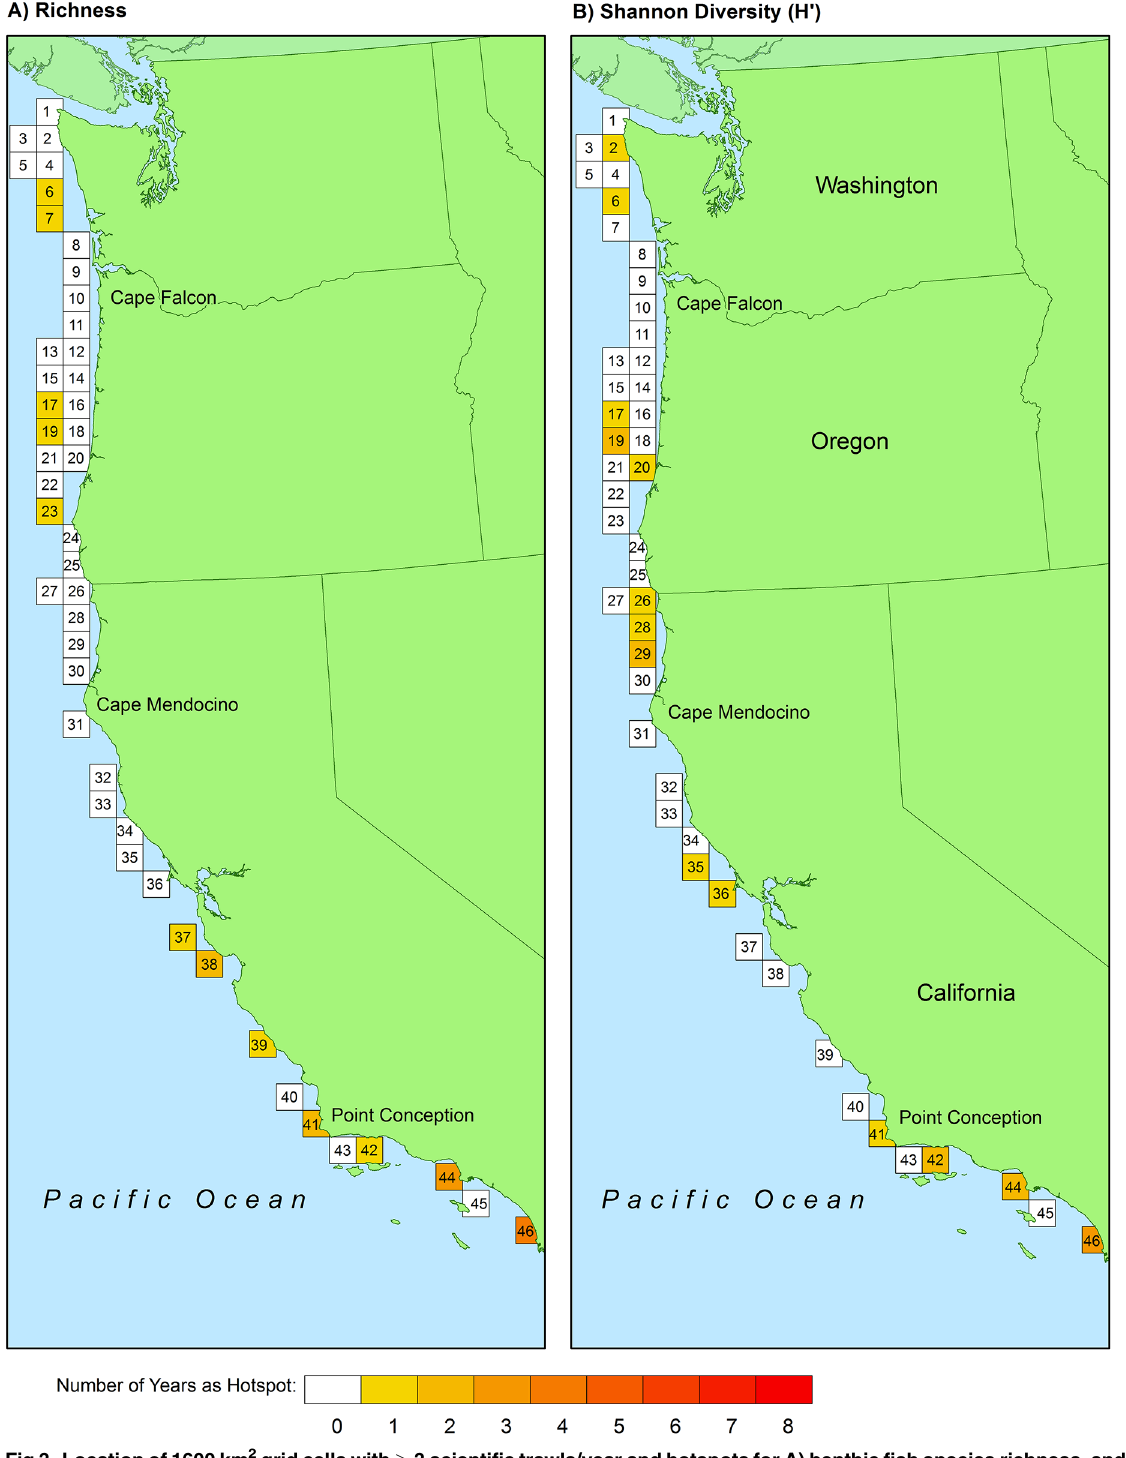
Fig 3. Location of 1600 km 2 grid cells with (cid:2) 3 scientific trawls/year and hotspots for A) benthic fish species richness, and B) benthic fish Shannon diversity, H 0 . Each grid cell contains an identification number and shading indicates the number of years (out of 8, 2003 – 2010) that the cell exceeded the universal threshold value to be classified as a hotspot (34.4 for species richness, 2.42 for Shannon diversity H 0 ).